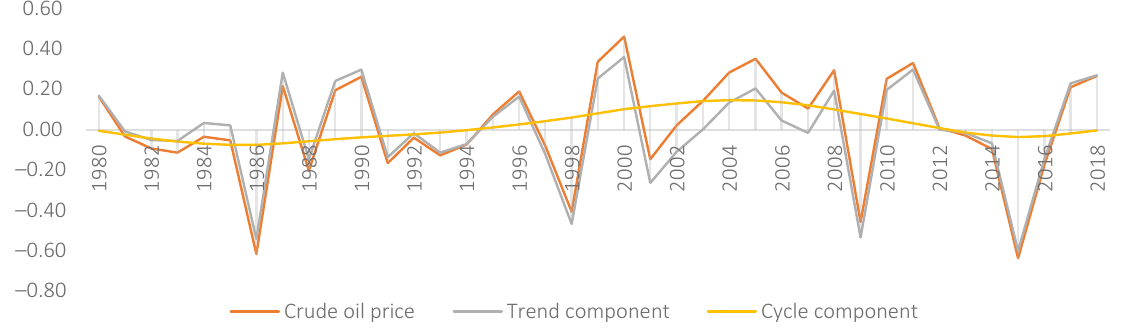
Figure 5. Deviation from trend of the oil price